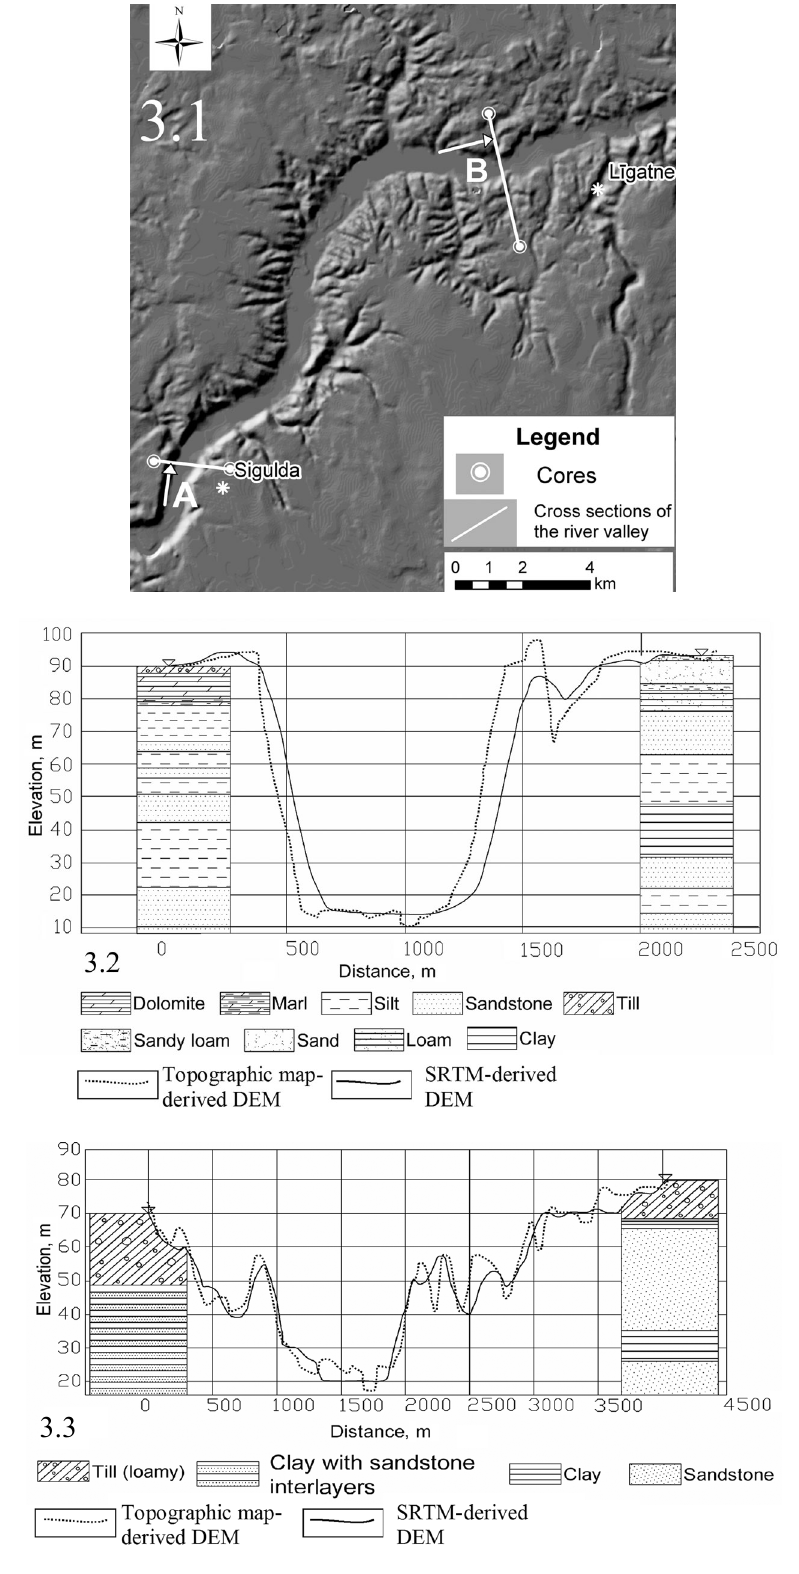
Fig. 3. Location of both cross sections in the study area (3.1). Cross sections A (3.2) and B (3.3) with comparison of SRTM- and topographic map-derived digital elevation models (DEM), and typical geological settings of the study